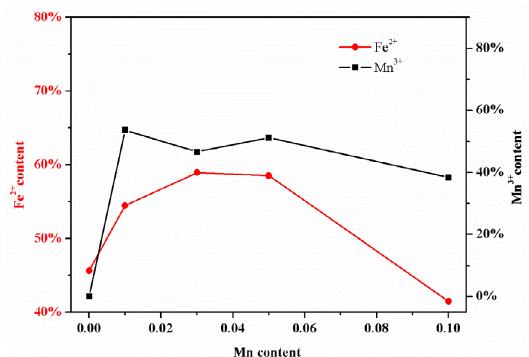
Fig. 5 Amount of Mn 4+ and Fe 2+ in the CuFe 1– x Mn x O 2